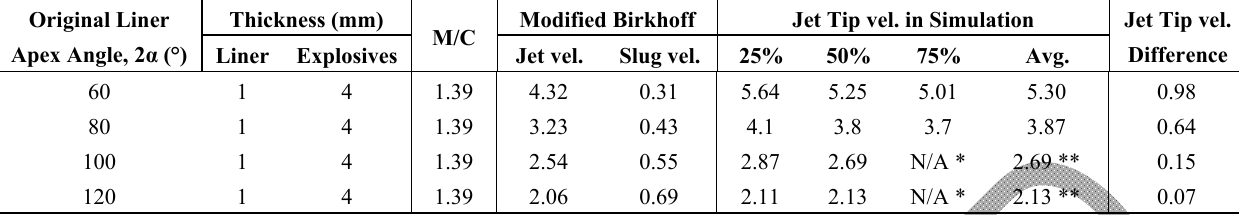
Table 3. Modified Birkhoff and numerical simulation